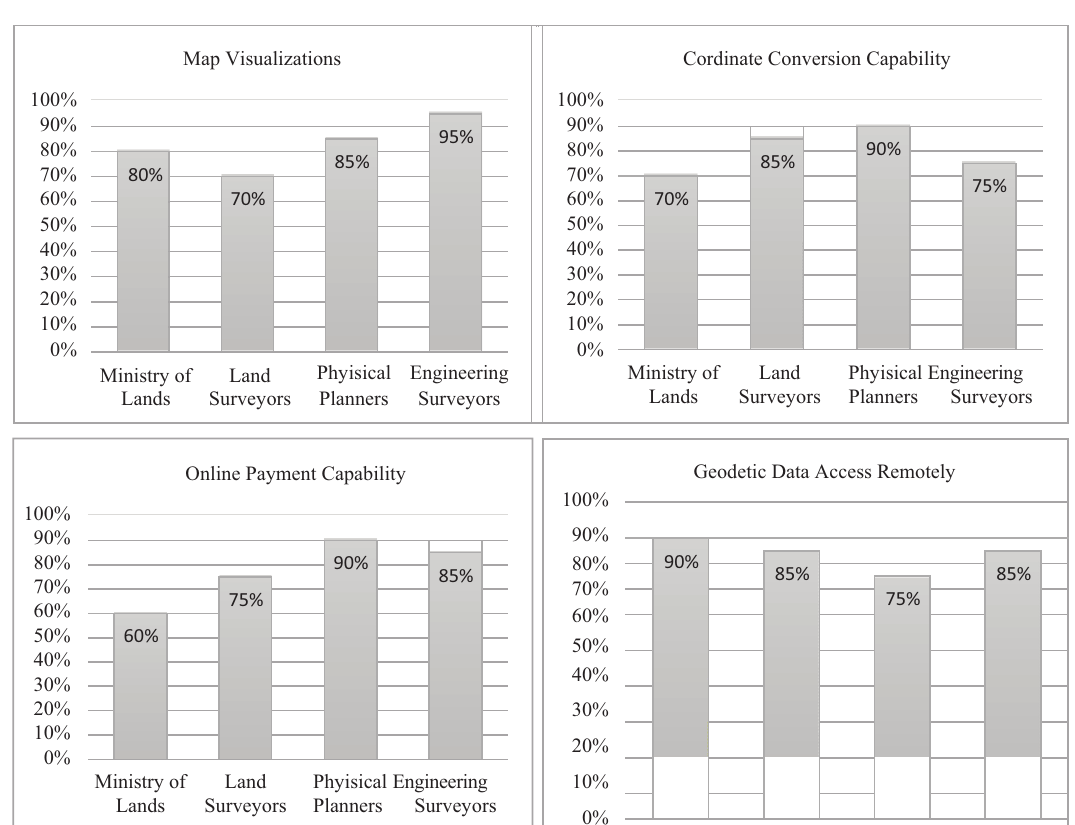
Figure 5. Response on working system